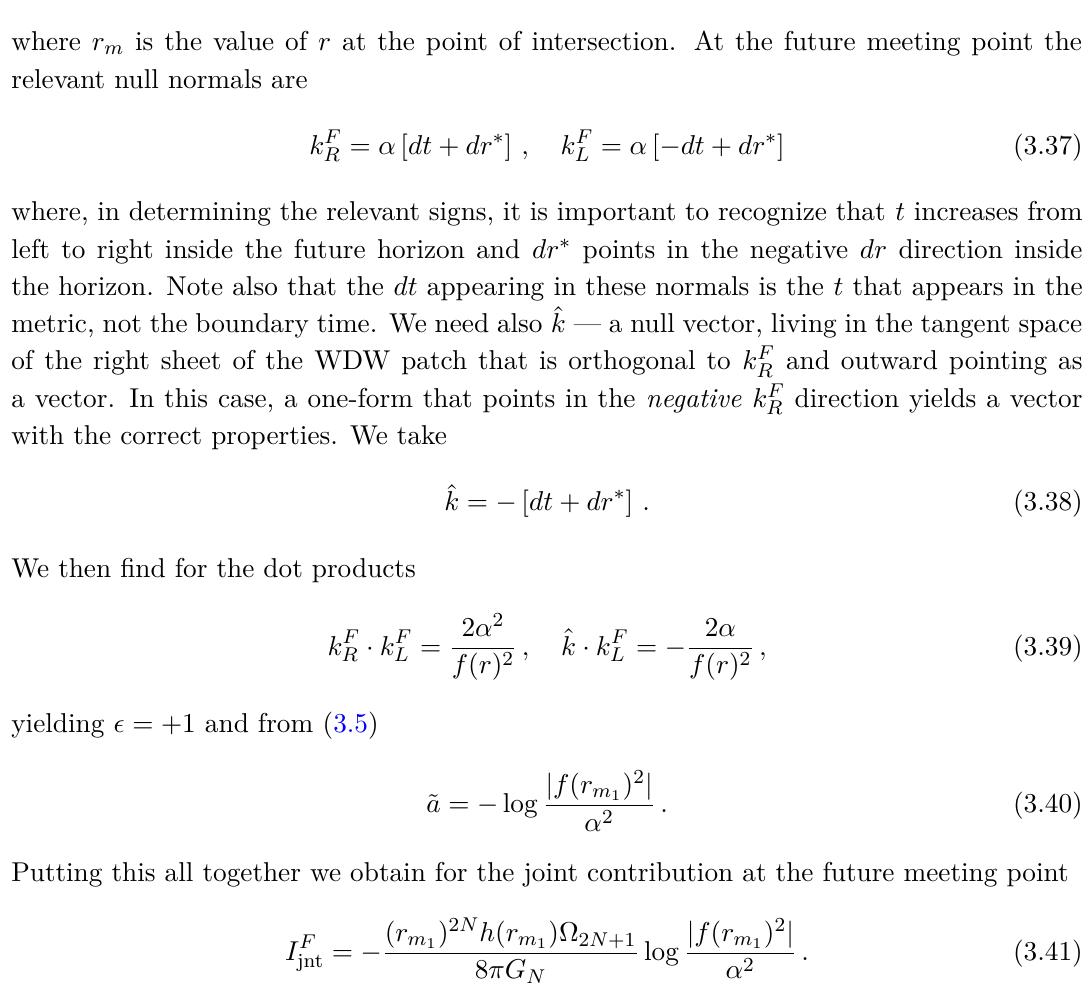
Figure 4. The joints in the WDW patch in figure 3 and the associated vectors needed to calculate their contribution to I WDW , according to